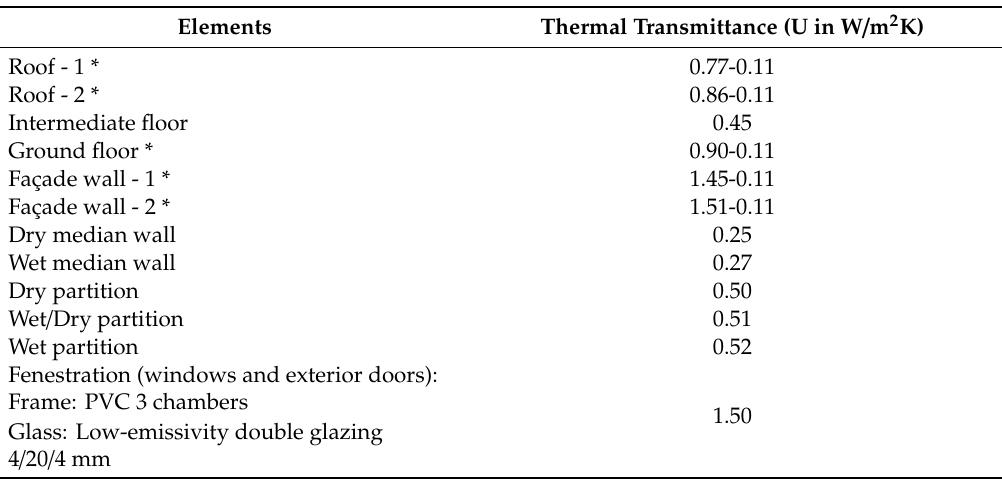
Table 5. Thermal transmittance (U-value) of di ff erent constructive